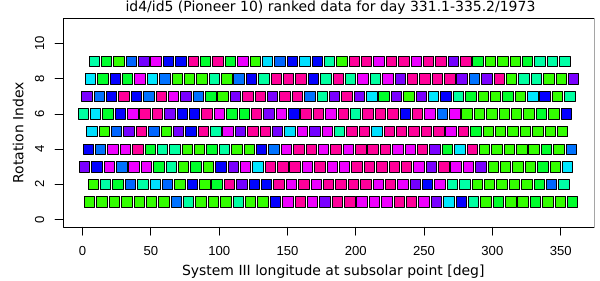
where ρ is the cylindrical distance of the spacecraft from the planet, θ d = 9 . 6 ◦ is the tilt angle of the dipole and λ the lon- Fig. 9. Same analysis as shown in Fig. 6 but for the Pioneer 10 gitude (System III). The prime meridian, i.e. the most North- 395 id4/id5 data during the inbound pass. Again, a recurrent maximum ern extend of the current sheet, is given as λ 0 = 20 . 4 ◦ . of the id4/id5 ratio is present at System III longitudes of ∼ 270 ◦ . A more realistic current sheet model was proposed by Khurana & Schwarzl (2005). This model takes into account However, similar to the Ulysses data, a second periodic enhance- an alignment of the current sheet with the solar wind flow di- ment is visible at 40 − 100 ◦ . Compared to Ulysses, this modulation rection at large distances as well as a bend-back of magnetic 400 is much weaker pronounced and less field lines and finite information propagation times. In this model, the distance of the magnetosphere from the equator is